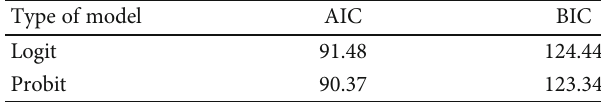
Table 5: AIC and BIC statistical results for goodness of fi t.